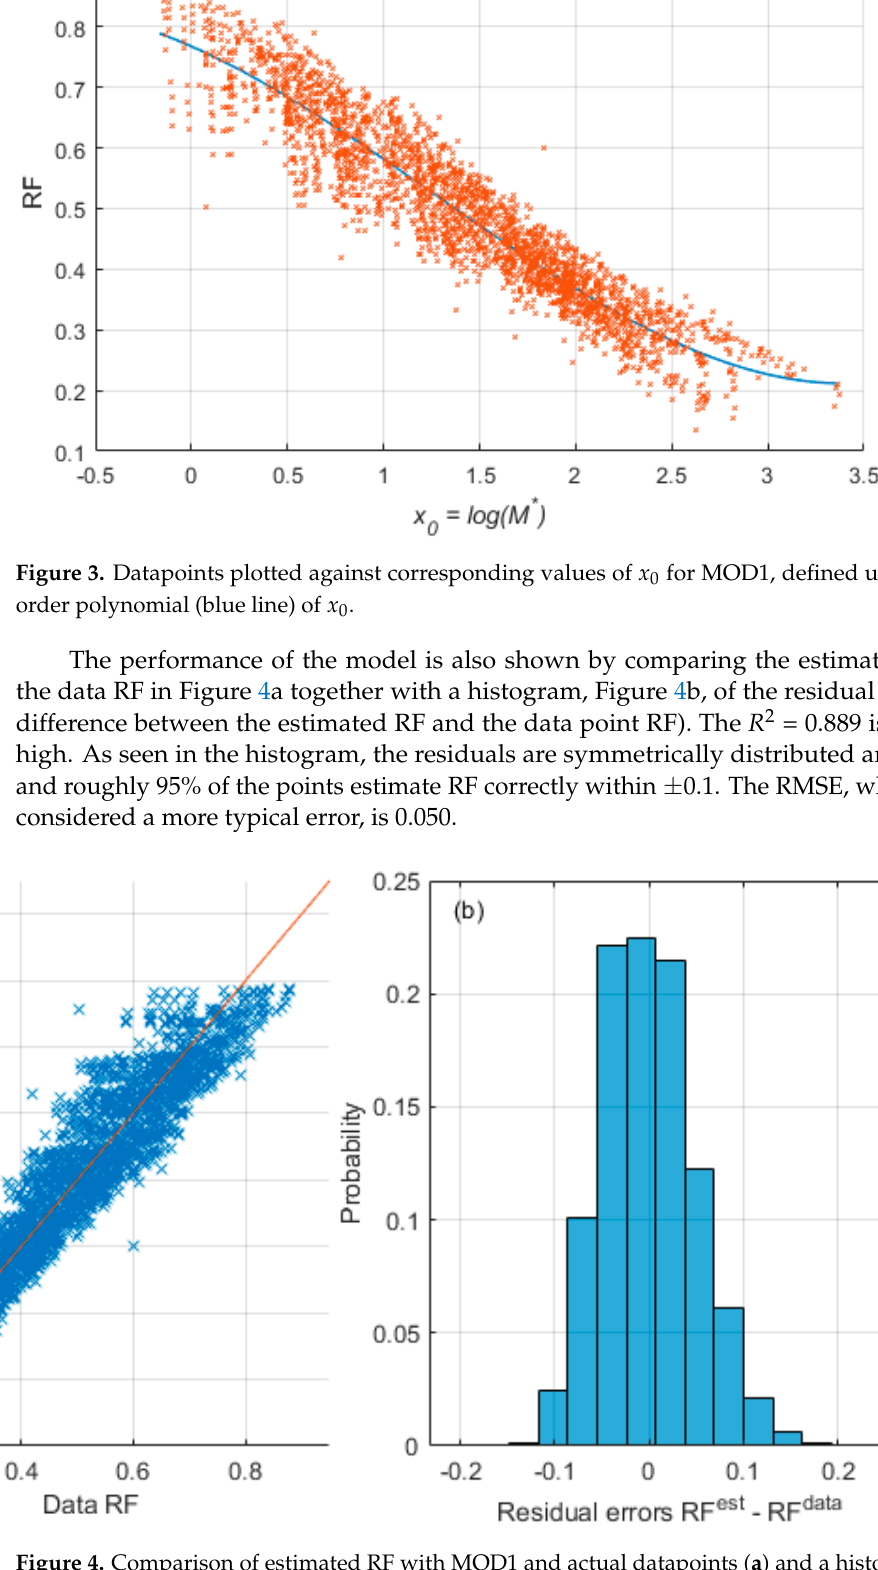
Figure 4. Comparison of estimated RF with MOD1 and actual datapoints ( a ) and a histogram of the residuals ( b ).